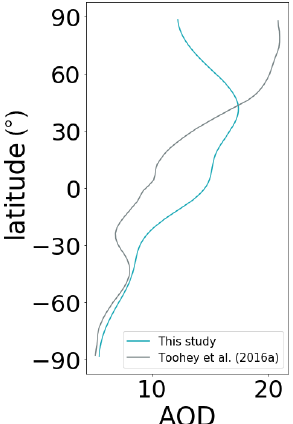
Figure A5. Comparison for accumulated AOD for 536–550CE for the volcanic forcing from this study (eVolv2k(EVA), Toohey and Sigl, 2017), and Toohey et al. (2016a) (their Fig. 2d, based on